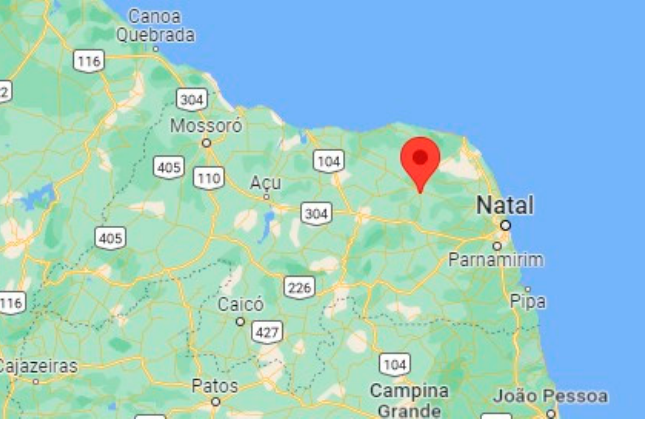
Figure 5. Jo ã o C â mara, RN, site installation with approximate location of the wind